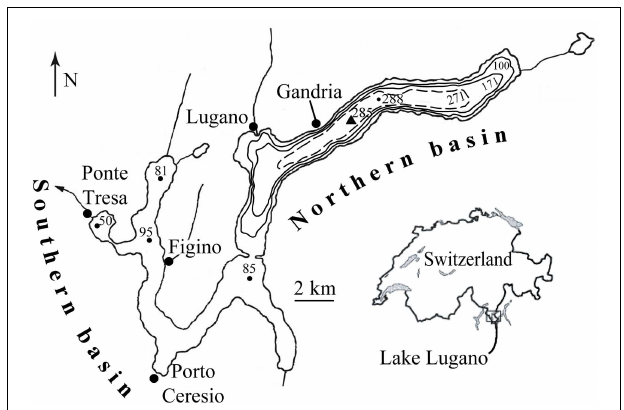
FIGURE 1 | Map of Lake Lugano. The black triangle indicates the sampling station near the deepest part of the northern basin. Small dots refer to water depths in